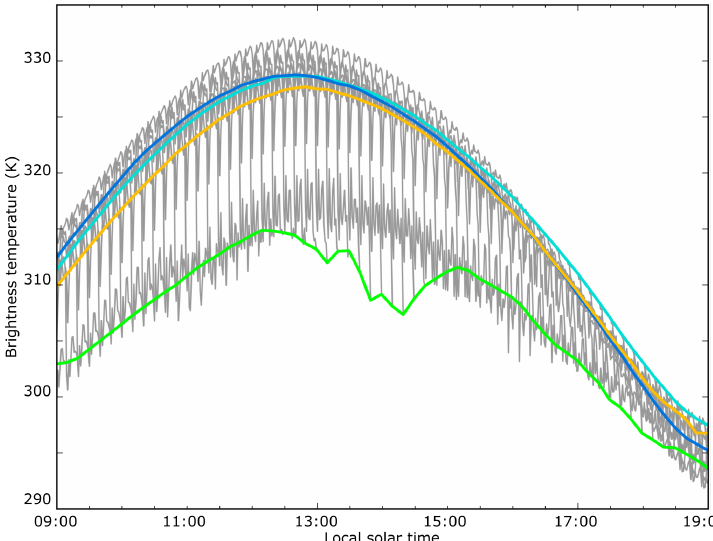
Figure 2. Figure 1 visualised relative to local solar time. Each of the swaths of block values extracted from each image are shown as a grey line. The four coloured lines depict the trajectory of individual block temperatures at 135 ◦ E, 140 ◦ E, 145 ◦ E and 150 ◦ E as the day passes.